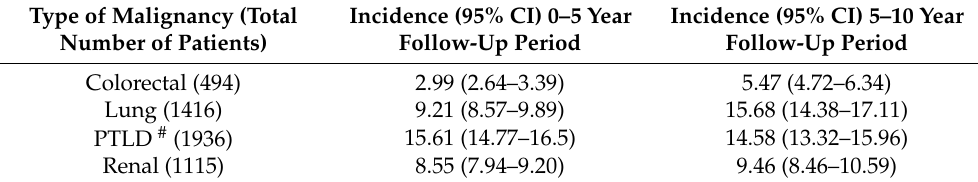
Table 2. Incidence rate per 10,000 person-years.